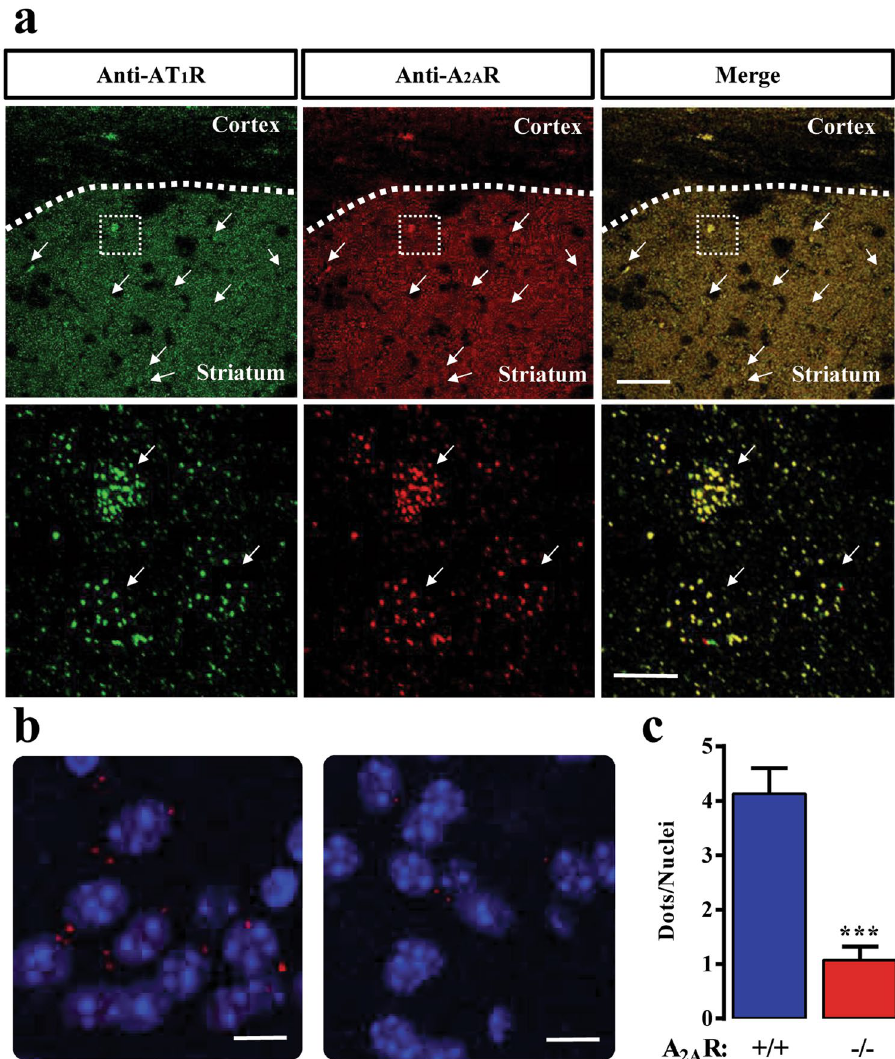
Figure 4. Detection of AT 1 R and A 2A R proximity in mice striatal sections. ( a ) Immunohistochemistry detection of AT 1 R and A 2A R in mice striatum. Representative confocal microscopy images of AT 1 R (red) and A 2A R (green) immunoreactivities in the striatum are shown. Lower panels show a magnification of the square area shown in the upper panel. Arrows indicate potential location of medium spiny neurons (MSN) cell bodies. Superimposition of images revealed a high receptor co-distribution in yellow (merge). Scale bars: 350 μ m (upper panels) and 10 μ m (lower panels). ( b ) Photomicrographs of dual recognition of AT 1 R and A 2A R with P-LISA. Representative images from wild-type (left) and A 2A R-KO (right) mice striatum. ( c ) Quantification of P-LISA signals for AT 1 R and A 2A R proximity confirmed the significant difference of P-LISA signal density between wild type and A 2A R-KO mice ( *** P < 0.001). Values in the graph correspond to the mean ± SEM (dots/nuclei) of at list three animals and 5 images per animal. Scale bar: 10 μ